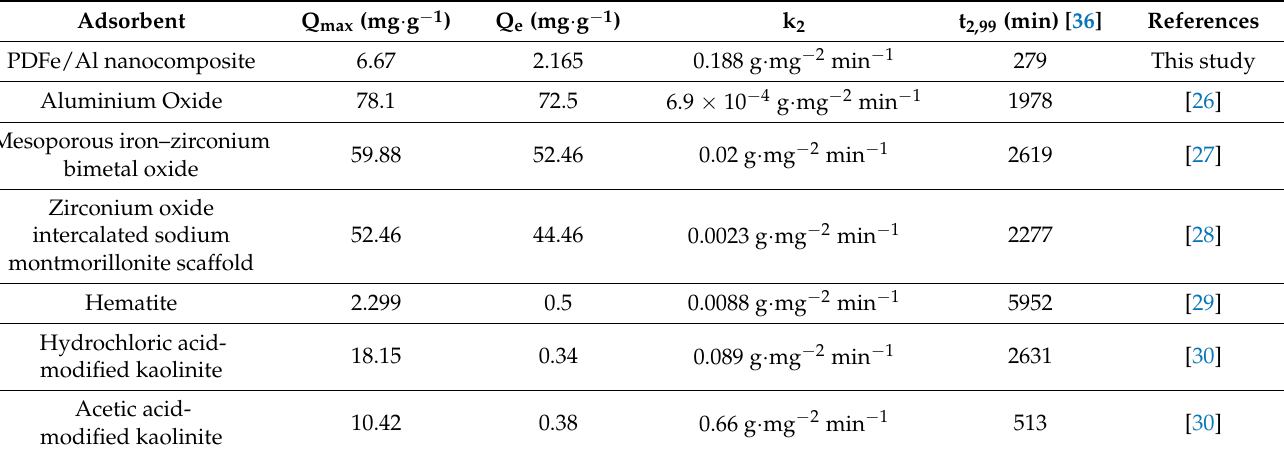
Table 7. Comparison of Fe/Al dimetal nanocomposite with other Fe and Al based adsorbents in the removal of